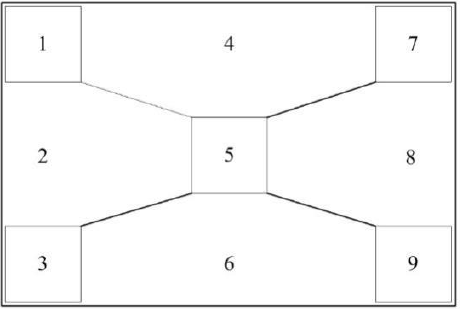
Figure 5. Diagram of the partitioning of the broiler living layer in the broiler chamber.